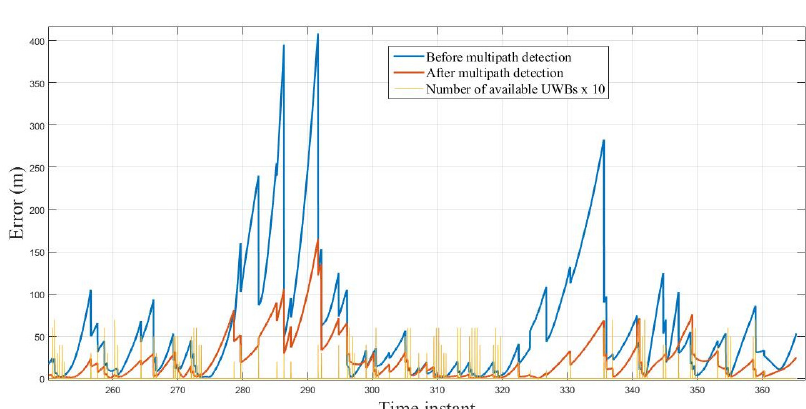
Figure 25. View3: Zoomed view of Figure